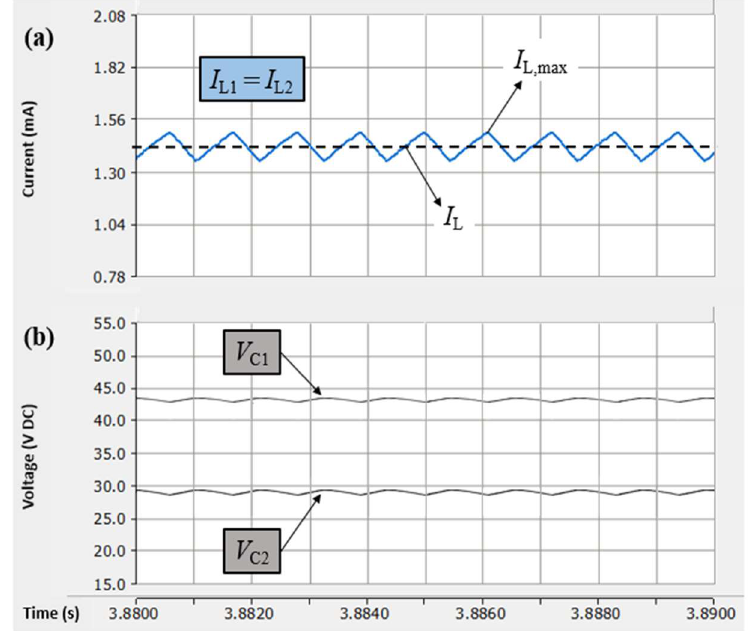
Figure 16. Transient response of respective passive components in the qZS network: ( a ) Inductor currents. ( b ) Capacitor voltages.